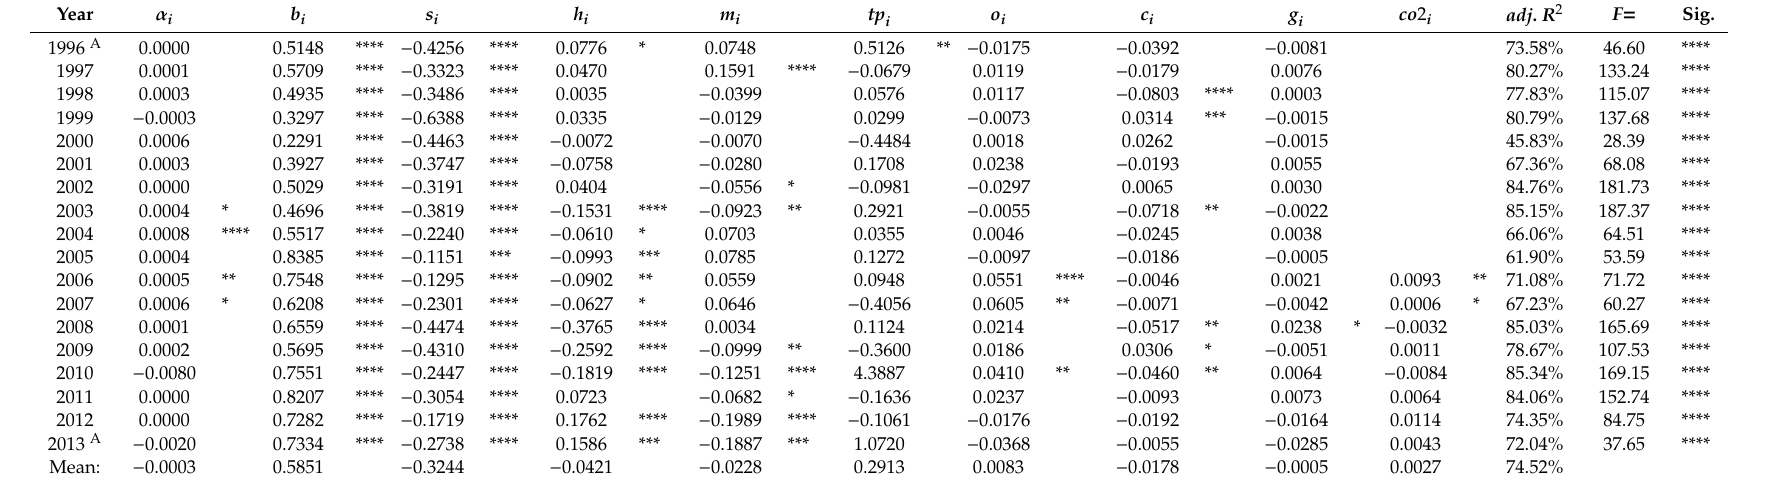
Table 3. Inter-temporal analysis of sector portfolio using the local “augmented” four-factor time series model